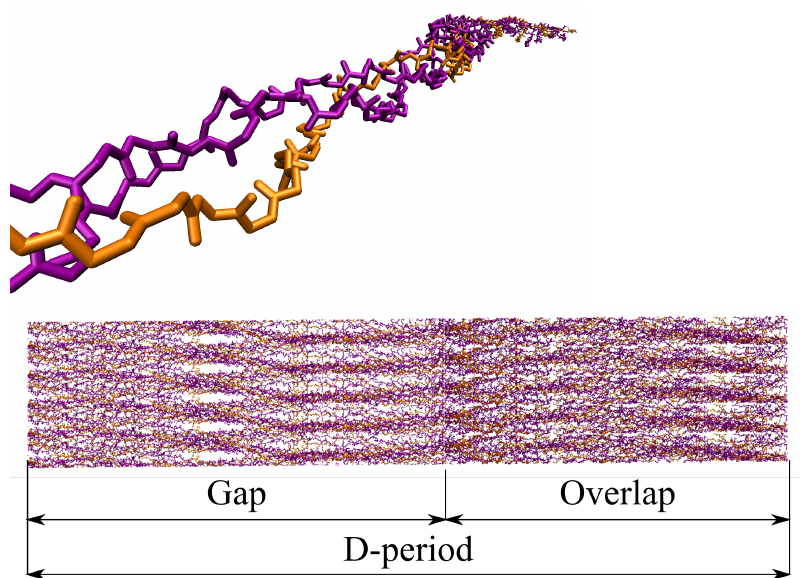
Figure 1. Structural representation of the backbone of a single molecule ( top ) and fibril ( bottom ) of the type I CLG. Chains A and C (alpha-1) are indicated in the purple color, and Chain B (alpha-2) in orange